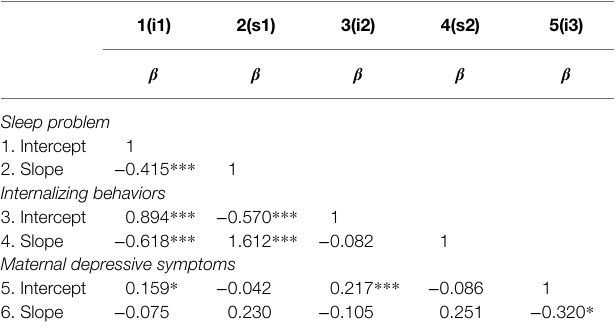
TABLE 7 | Coefficients among growth factors in multivariate growth model 4: sleep problem—internalizing